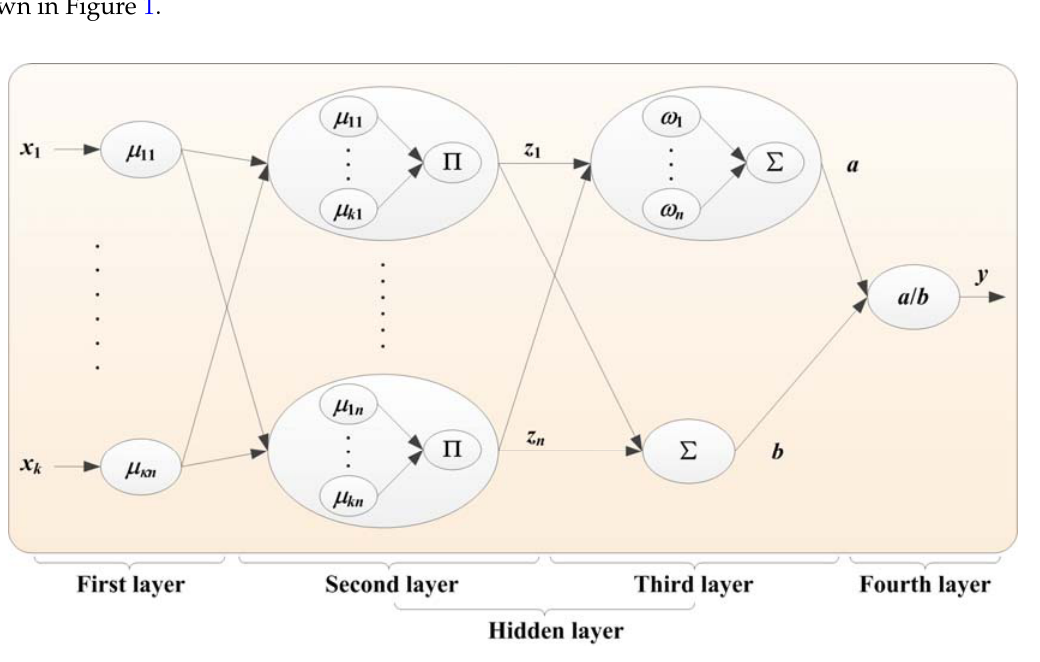
Figure 1. The architecture of a four ‐ layer fuzzy neural network.